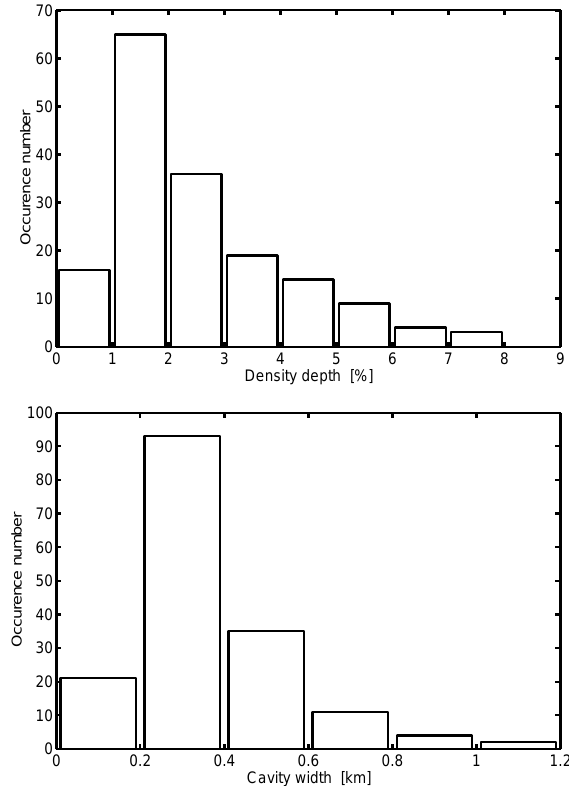
Fig. 8. The distribution of the depths and widths of the identified Viking LHCs. The widths are determined under the assumption that the spacecraft passes the cavity with the typical perpendicular velocity of